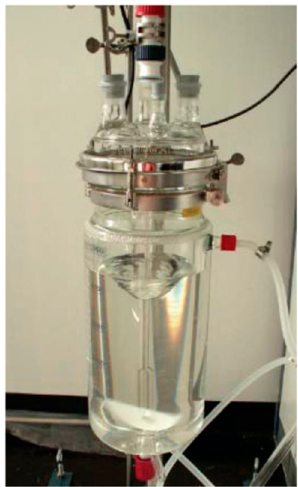
Figure 5. MgF 2 sol stabilized by Al(O i Pr) 3 after 2 days of fluorination prepared in a 10 L reactor. Reproduced from Reference [37] with the permission of the Royal Chemical Society.